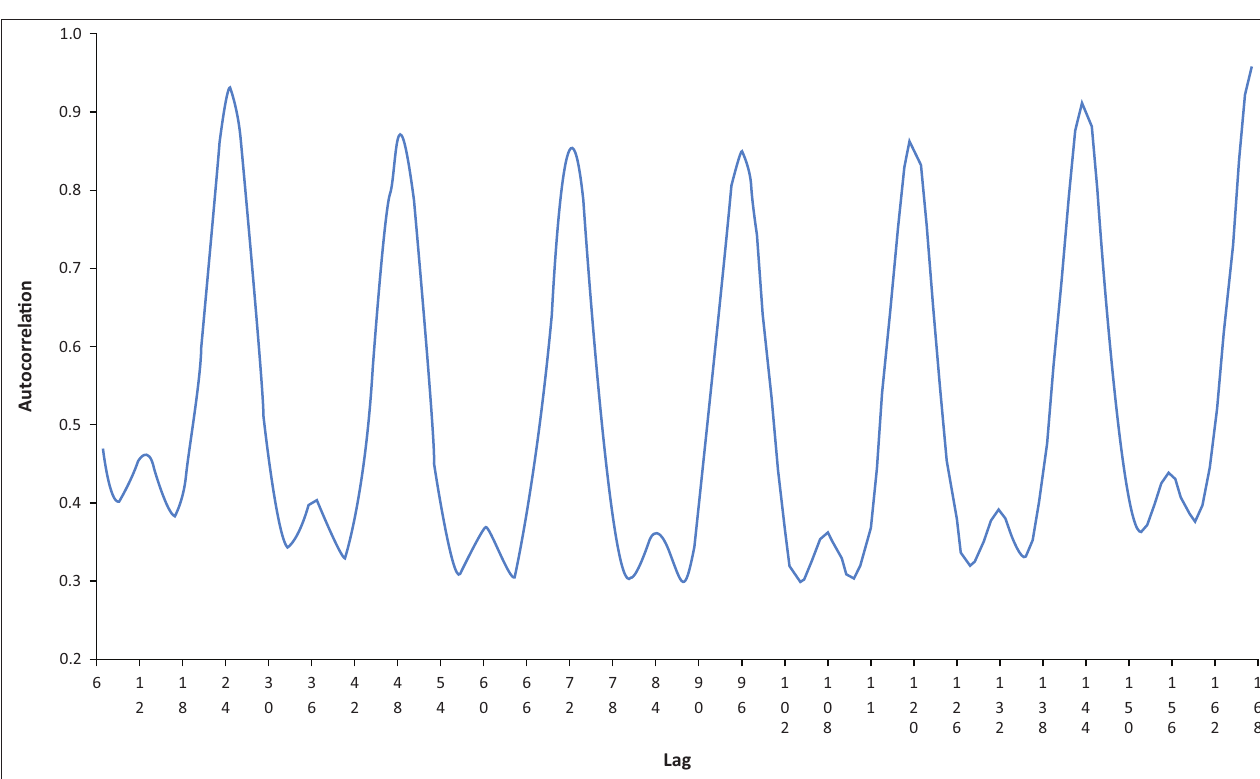
FIGURE 1-A2: The autocorrelation plot: Correlation of hourly electricity demand